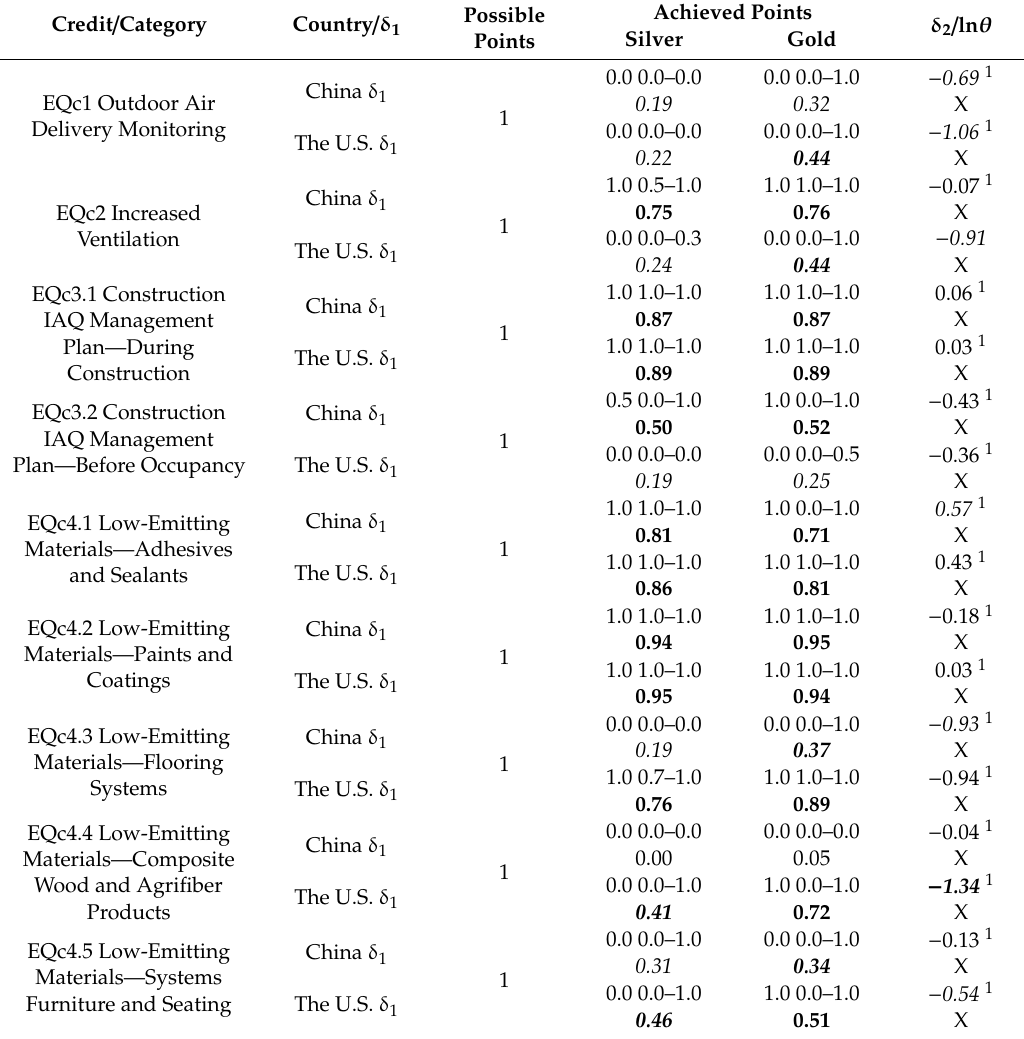
Table 9. LEED-CI v3 Indoor Environmental Quality (QE) credits category: The median and 25th–75th centiles and Cli ff ’s e ff ect size ( δ 1 ) of the di ff erence between the achieved and the possible points, and ( δ 2 ) or ln θ of the di ff erence between Silver and Gold projects in China and the